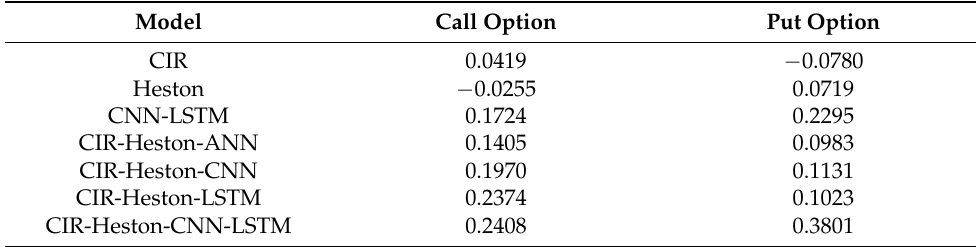
Table 7. Ridge regression coefficient table.